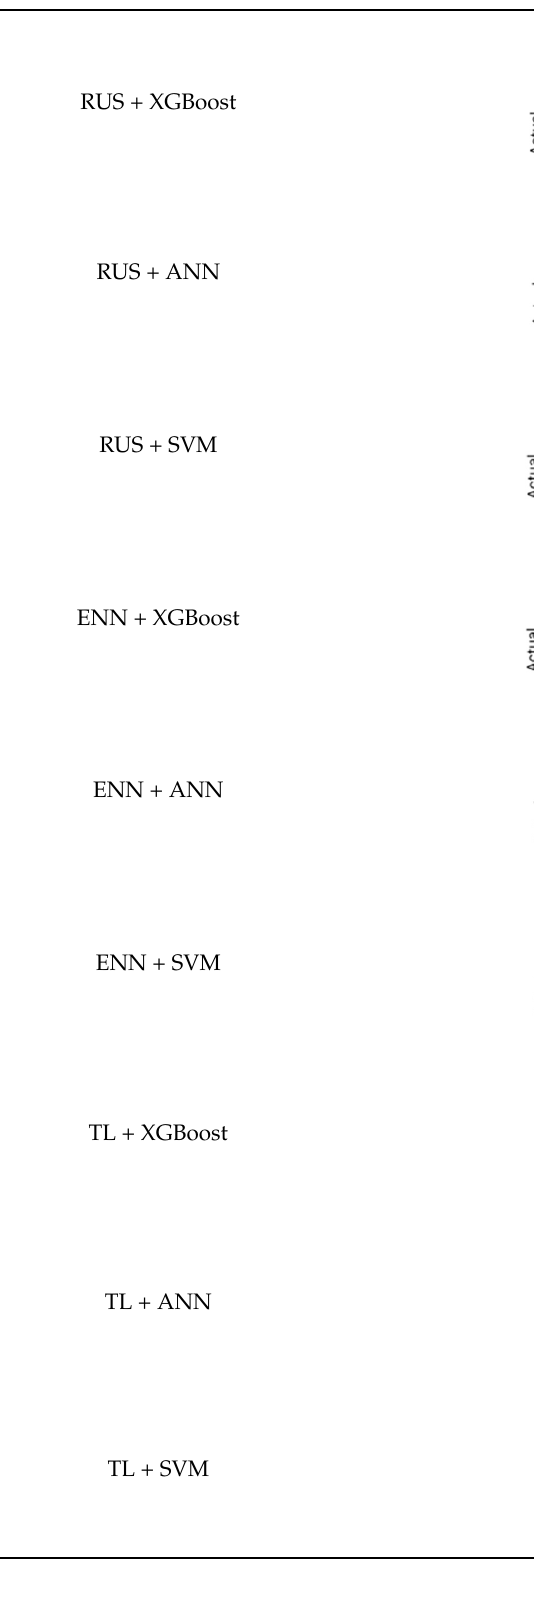
Table 11. Confusion matrix of the fusion model for datasets balanced using hybrid sampling tech- niques.